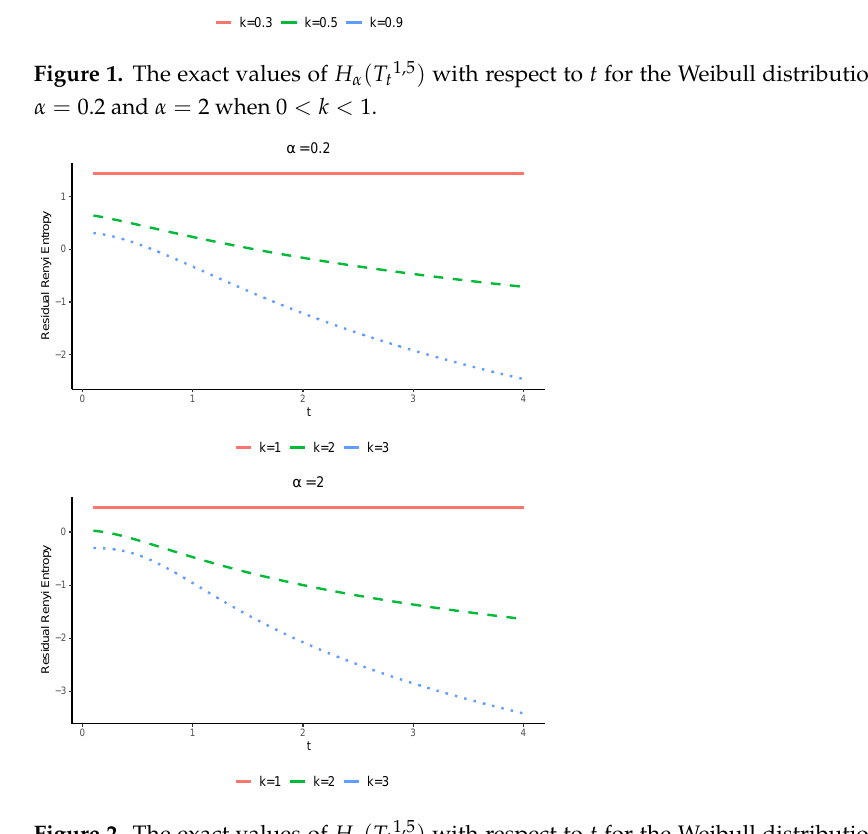
Figure 2. The exact values of H α ( T t 1,5 ) with respect to t for the Weibull distribution for values of α = 0.2 and α = 2 when k ≥ 1. Below, we compare the Renyi entropies of two coherent system lifetimes and their residual